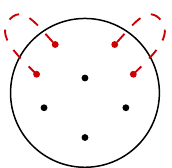
Figure 1 . Sphere with two nodes, through which the two loop momenta